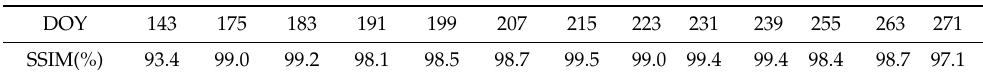
Figure 3. Normalized difference vegetation index (NDVI) visual results of SIM (the upper image of each pair is the input and the lower is the output) at the CSD area for all input days. The blanks and gaps at the upper images in each pair result from the removal of clouds, cloud shadows, and scan line corrector failure. Table 1. Structural similarity measure (SSIM) between input and output NDVI images for the CSD area.